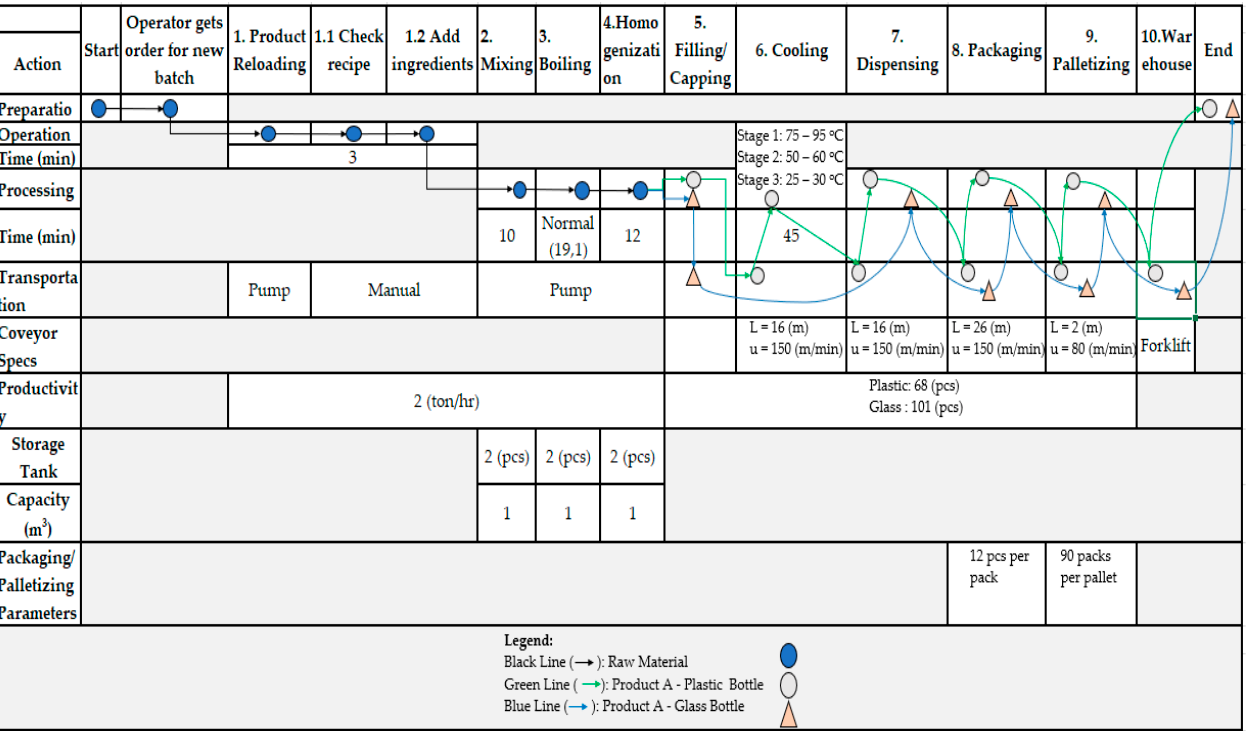
Figure 9. Flow Process Chart of the Production Line.